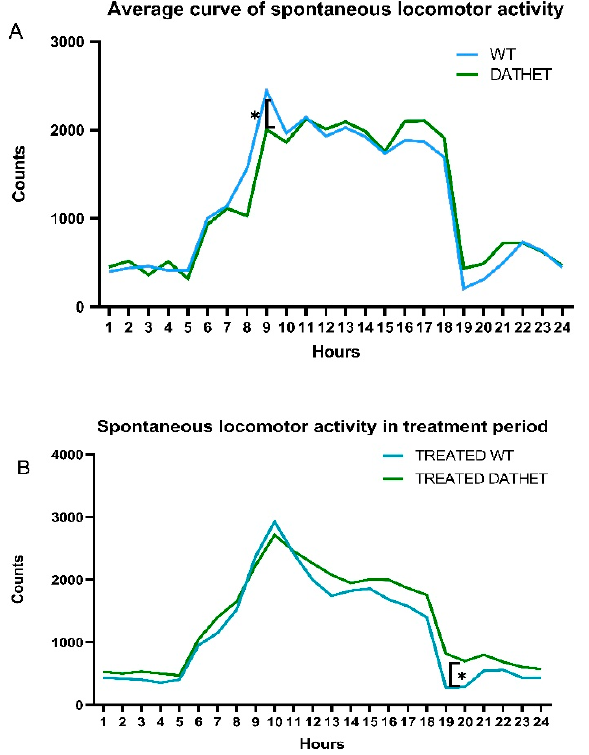
Figure 5. ( A ) Average 24-h curve of spontaneous locomotor activity of all experimental subjects during pre-treatment period ( n = 20); ( B ) Average 24-h curve of spontaneous locomotor activity for Moringa -treated groups of either genotype ( n = 5/6) during the whole treatment